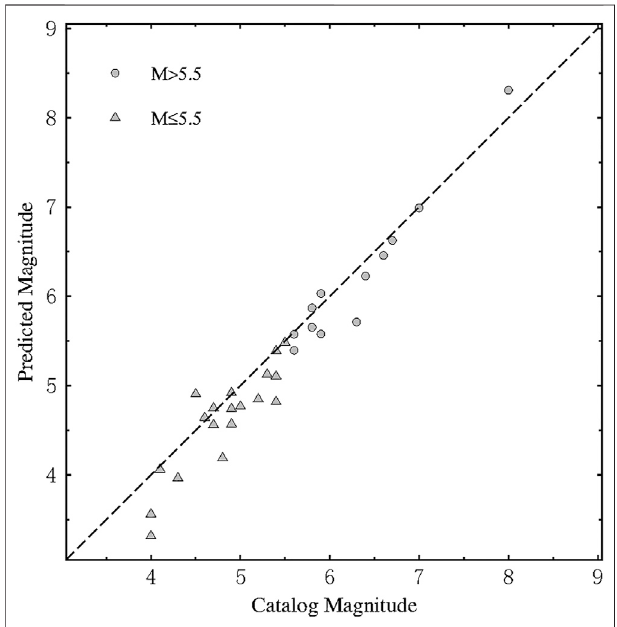
FIGURE 7 | The estimation of the magnitude and catalog magnitude. The dashed line corresponds to the 1:1 scaling. The triangles and circles indicatetheestimated magnitude withP L *usingtherelation coef fi cients Aand B for a fi xed 3 s PTW and a fi xed 9 s PTW, respectively.